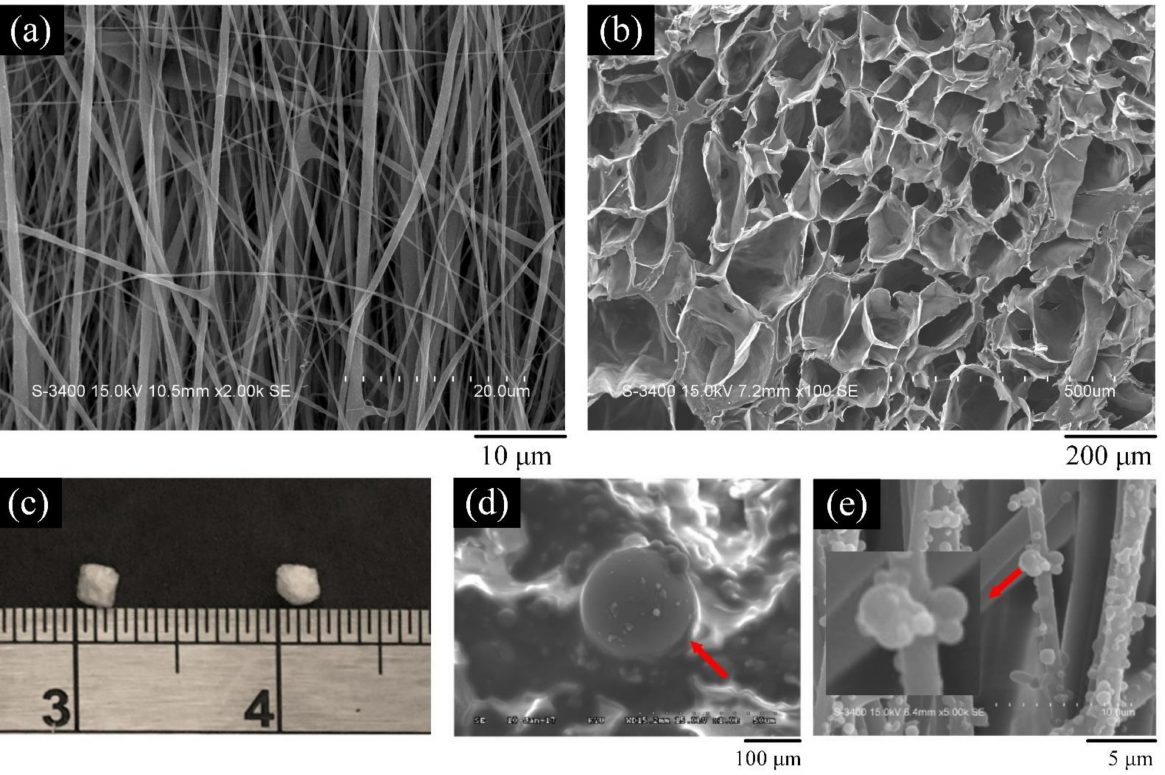
Figure 6. Appearances of ( a ) electrospun film; ( b ) freeze-dried scaffold; ( c ) freeze-dried beads ( d ) microspheres, and ( e ) electrospray